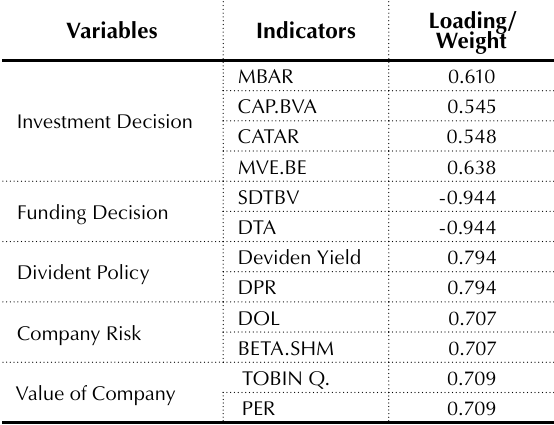
Figure 1. Development of average. Average Value Risk Indicators in Sector Property and Real Estate Year during 2001–2008